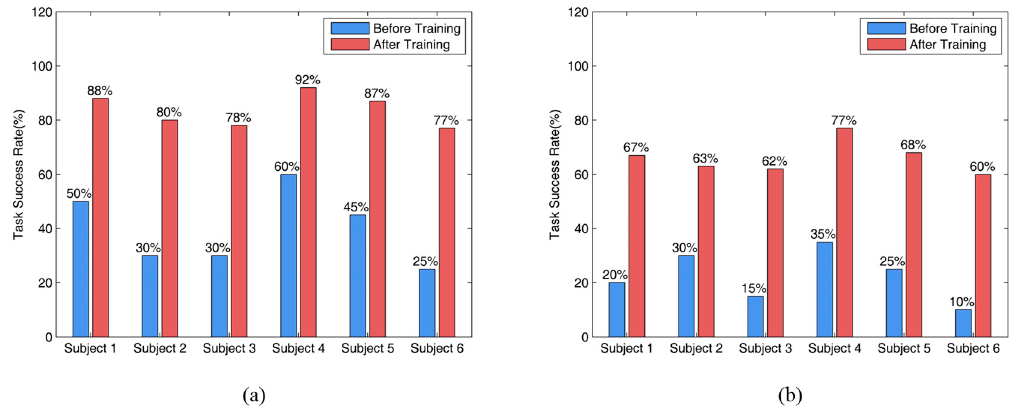
Figure 10. Task success rate of two-dimensional cursor control training. ( a ) Task 1. ( b ) Task 2.